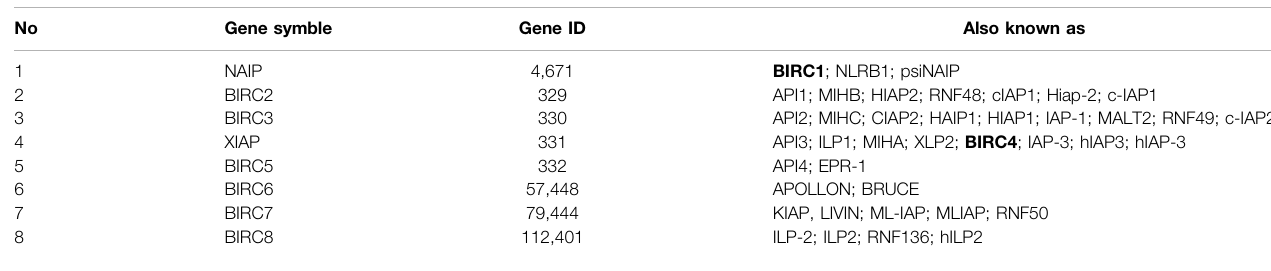
TABLE 1 | Inhibitor of apoptosis proteins